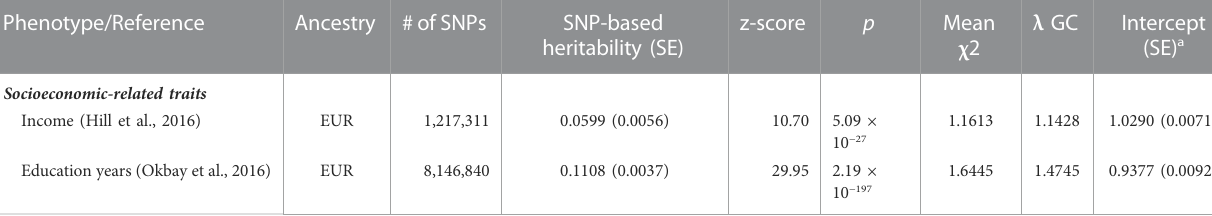
TABLE 2 ( Continued ) Results of univariate SNP-based heritability estimates using LD-score regression of predicted probability of suicidal behaviour (SB), psychiatric disorders and education in years and